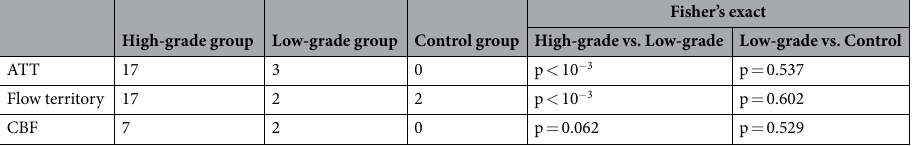
Table 2. Frequency of perfusion asymmetry in high-grade group (N = 20), low-grade group (N = 22), and control group (N = 12).